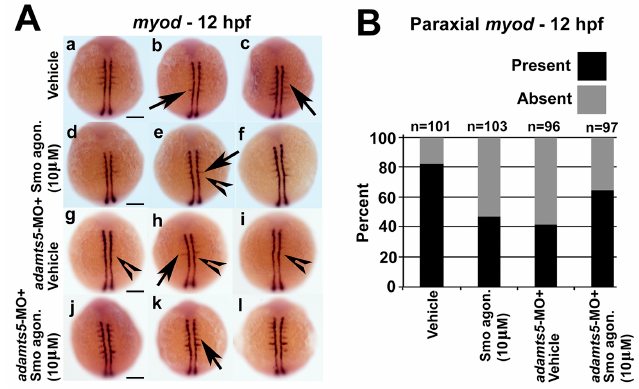
Figure 5. Combinatorial activation of Shh signaling and inhibition of adamts5 rescues paraxial myod expression. ( A ) Adaxial and paraxial myod expression in 12 hpf embryos treated with vehicle control ( a – c , arrows), 10 µ M Smoothened agonist (Smo agon.) ( d – f , arrow/open arrowhead represent present/absent myod expression in paraxial mesoderm), vehicle + adamts5 -MO ( g – i , arrow/open arrowhead represents present/absent myod expression in paraxial mesoderm) and 10 µ M Smo agon. + adamts5 -MO ( j – l , arrows indicate myod expression present in paraxial mesoderm). Scale bar = 100 µ m; ( B ) Quantitation of embryos showing present or absent myod patterning represented in ( A